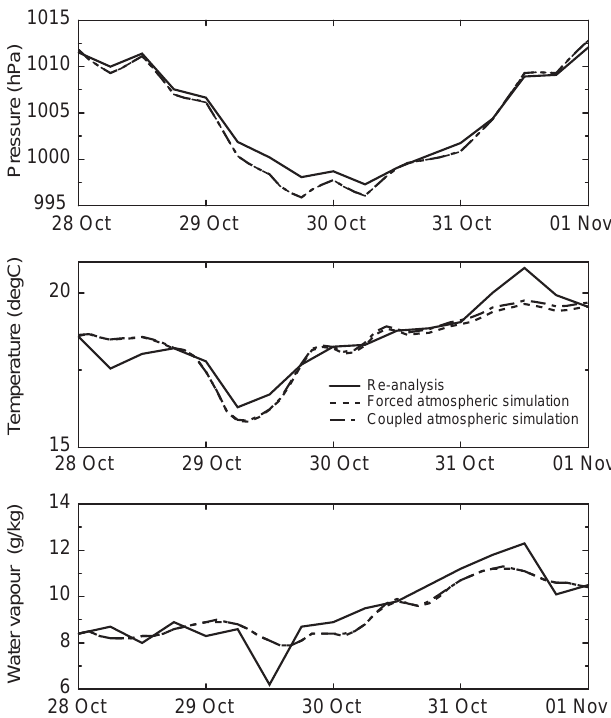
Fig. 3. From top to bottom: evolution of pressure, temperature and water vapour mixing ratio averaged on the simulation domain at the lowest Meso-NH vertical level (20 m). ARPEGE re-analysis ( solid line ), forced Meso-NH simulation ( dotted line ) and coupled Meso-NH simulation ( dashed line )